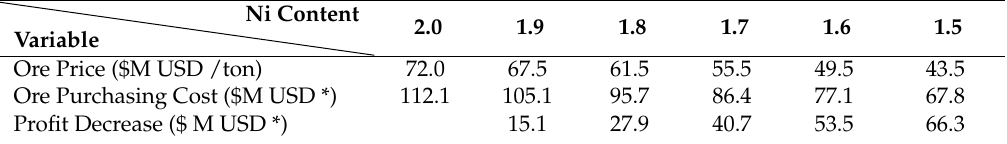
Table 6. Cost and profit with Ni content variation (fluctuating price ratio).